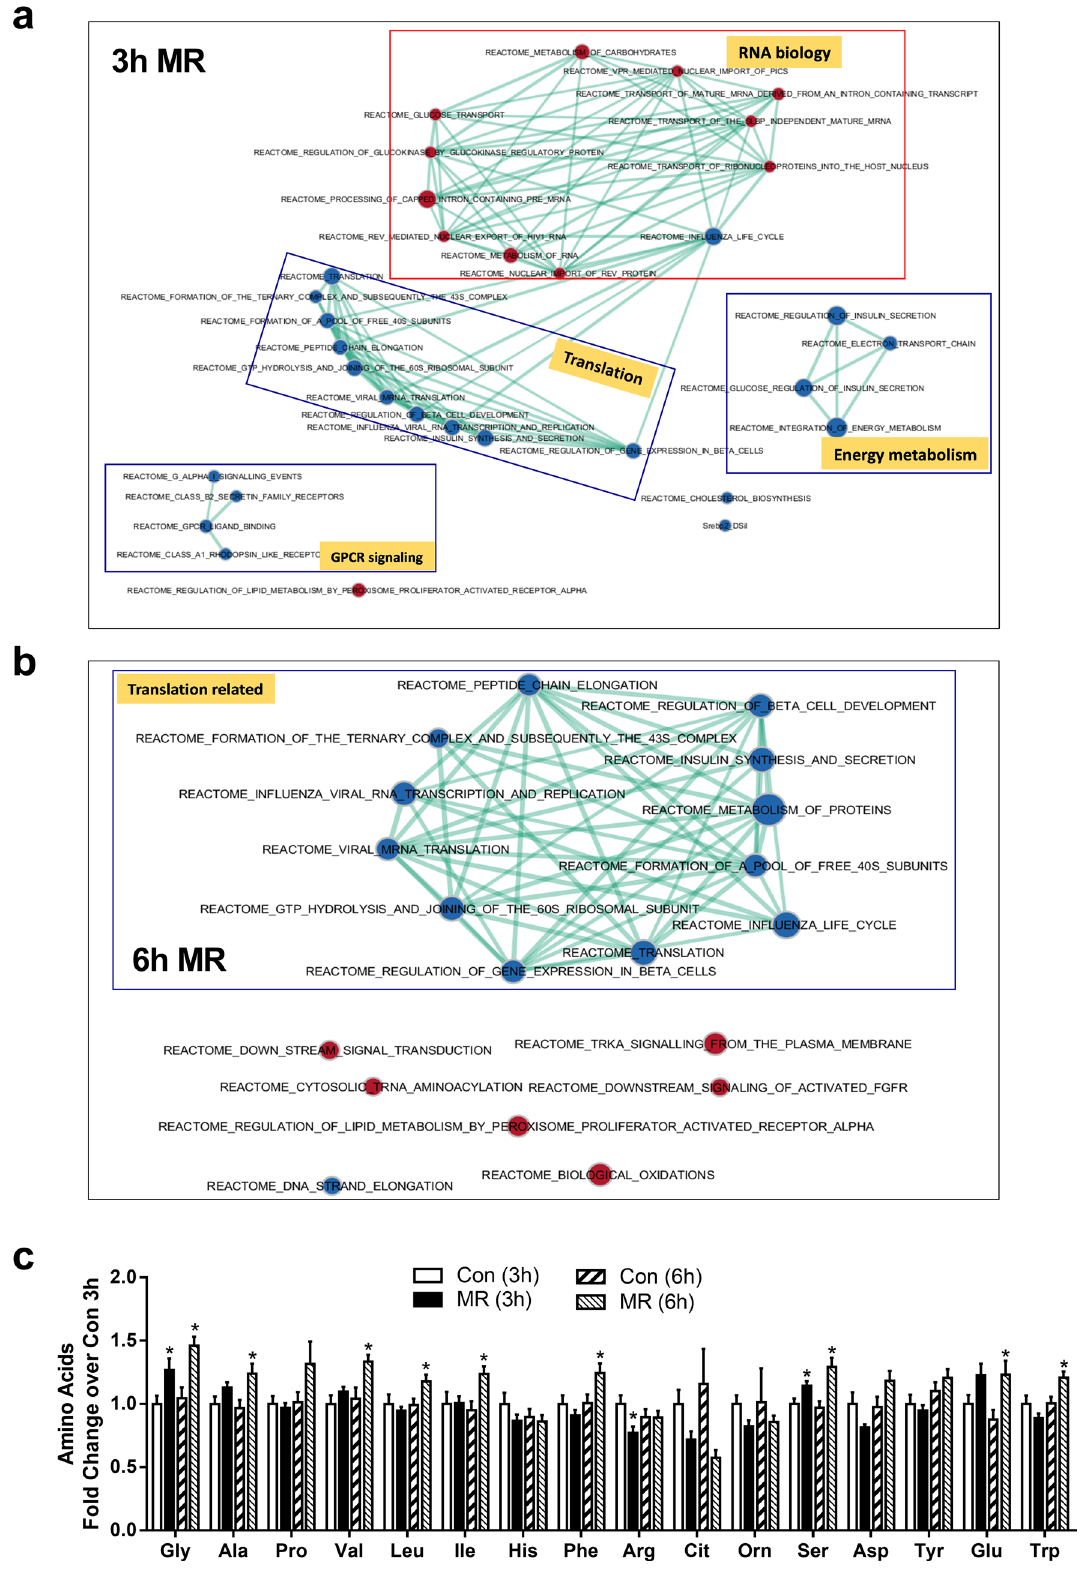
Figure 2. GSEA from livers of mice exposed to Con or MR for either 3 h ( a ) or 6 h ( b ). GSEA was derived from RNAseq of each 6 liver samples from mice fed either Con or MR for 3 h and 6 h and analyzed as described in Methods. Data was analyzed via EnrichmentMap (version 2.2.1, apps.cytoscape.org/enrichmentmap) and visualized in Cytoscape (version 3.8.0, www.cytos cape.org). ( c ) Hepatic amino acids of mice exposed to Con or MR for 3 h and 6 h were quantified using metabolomics analysis. Data were obtained from n = 8/group and compared between Con and MR for each time point using unpaired t-test *p < 0.05. Data are presented as fold induction from Con at 3